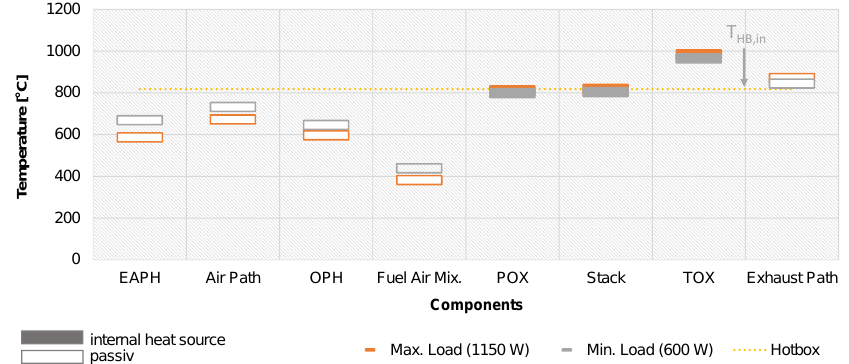
Figure 18. Modeled temperature levels of the hotbox components and relevant piping for the maximum and the minimum load points with indication of the virtual heat capacity temperature (all based on simulation results).